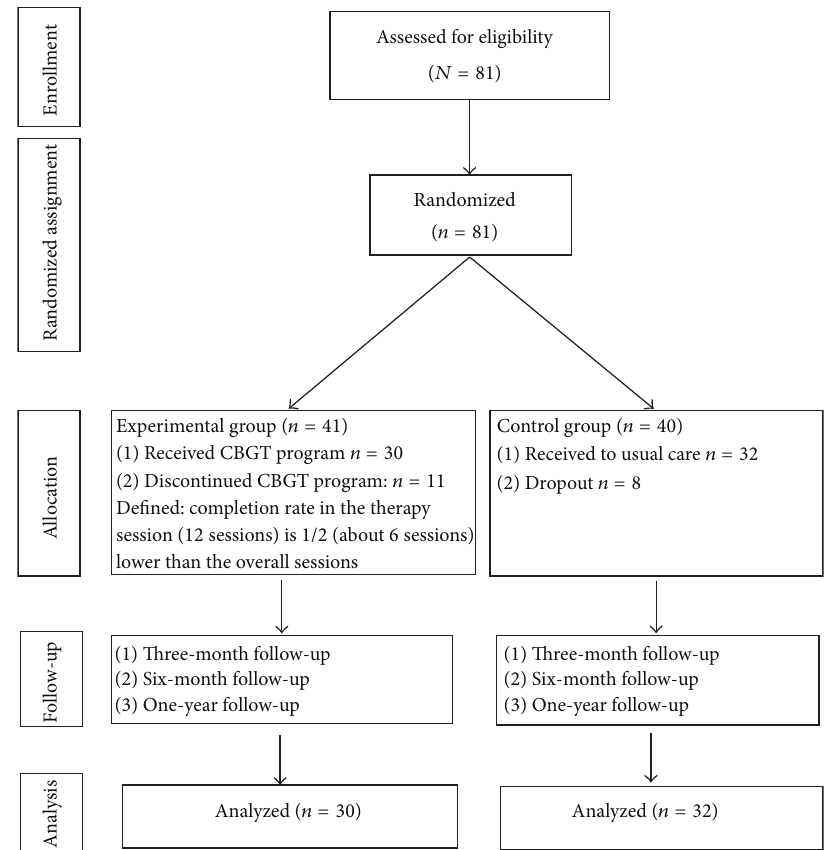
Figure 1: Participant flow at each step after